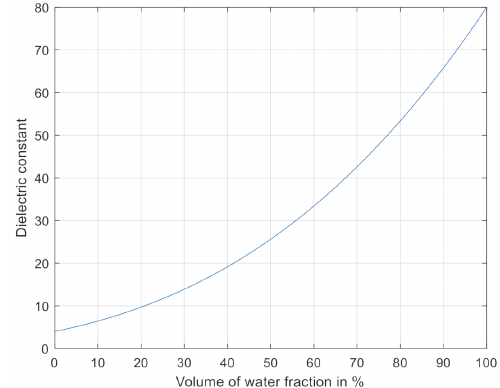
Figure 2. Dielectric constant of a soil-water mixture.